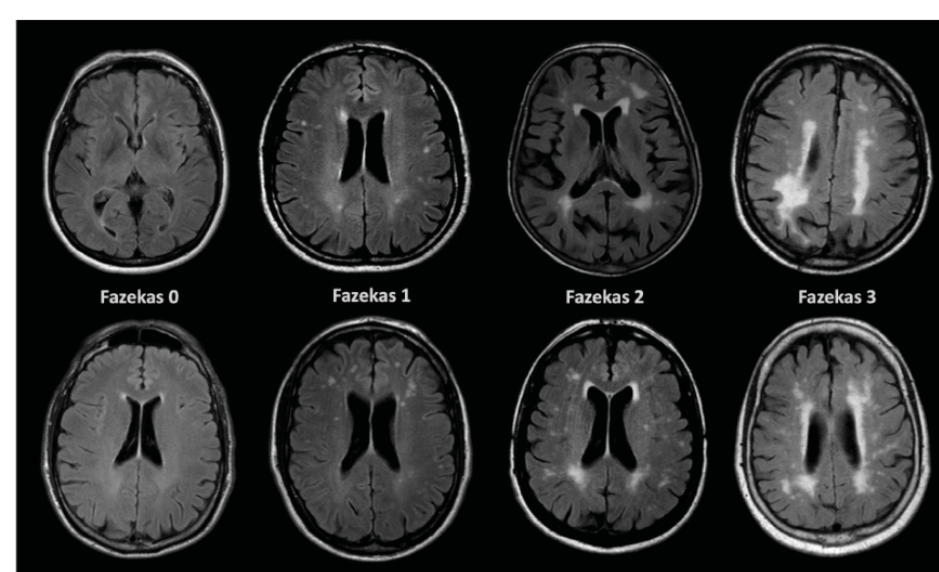
Figura 5. Avaliação das Hiperintensidades de Substância Branca conforme a escala visual de Fazekas 107